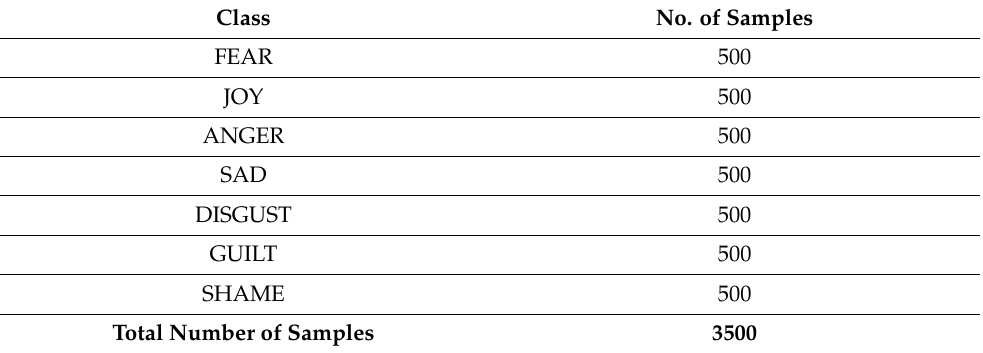
Table 1. Dataset